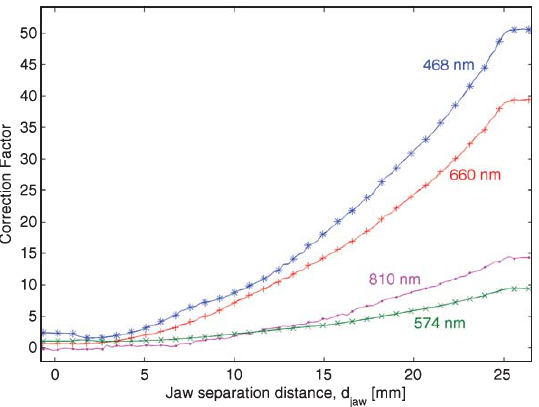
Fig. 12. Measured values of photodiode responsivity match well to the supplied responsivity curve.